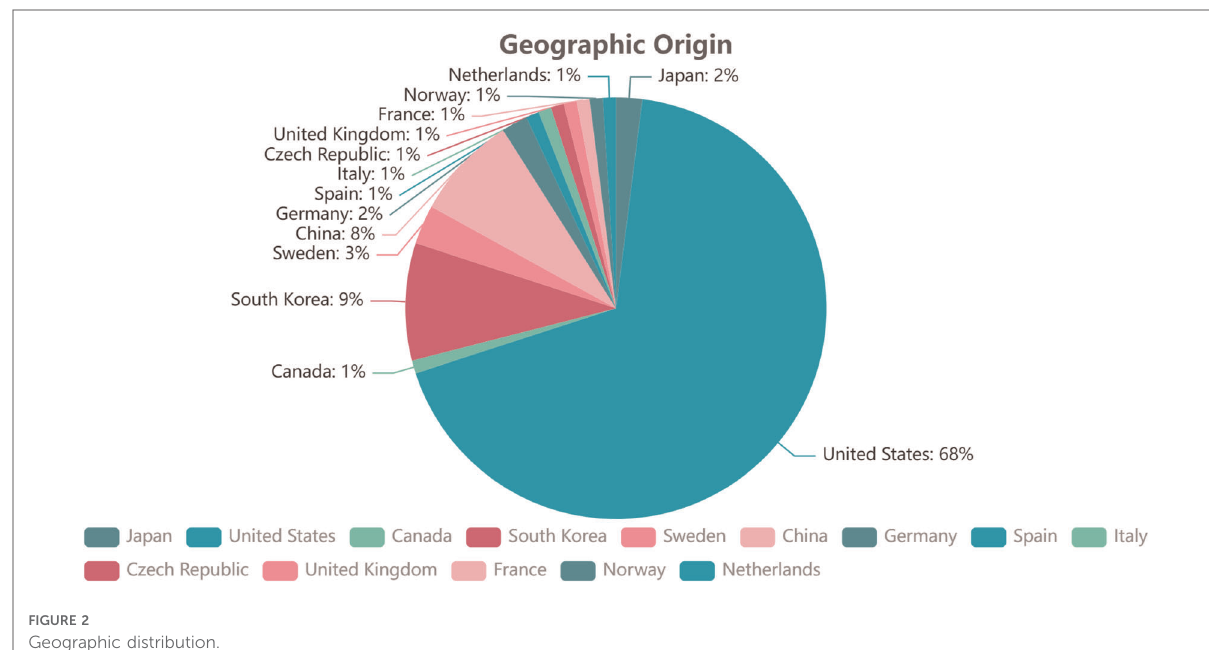
FIGURE 2 Geographic distribution.